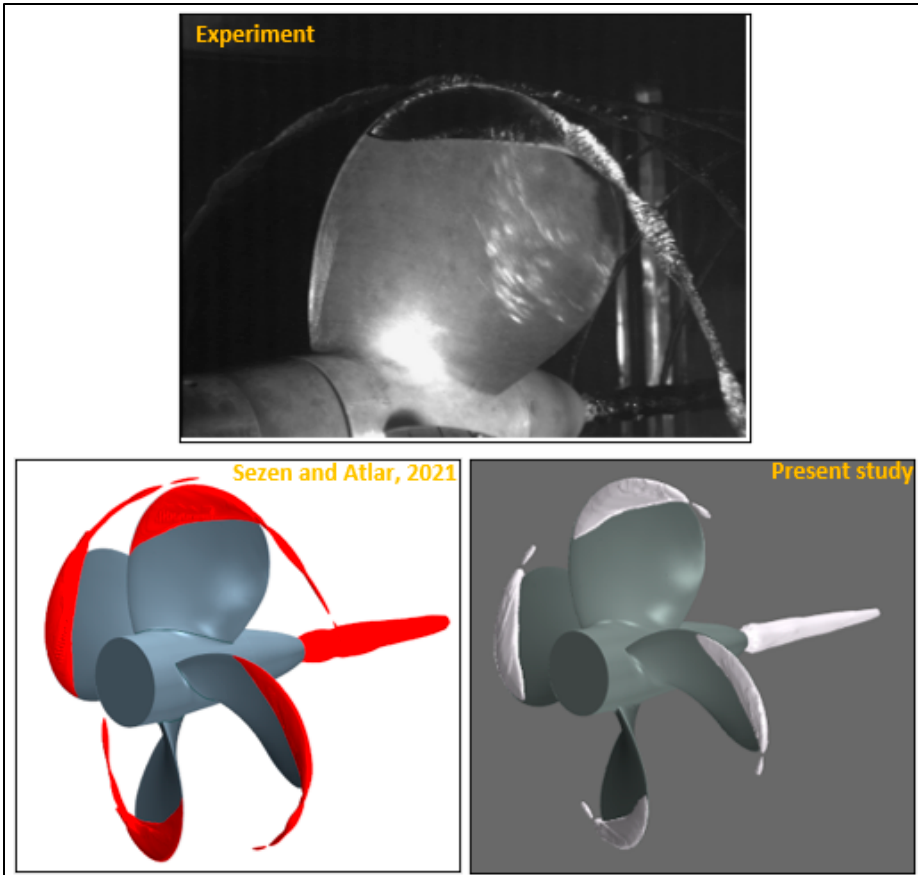
Figure 4. Comparison of cavitation extensions between CFD and experiment at J = 0.71, σ = 1.763 in smooth condition ( α v = 0.1 )